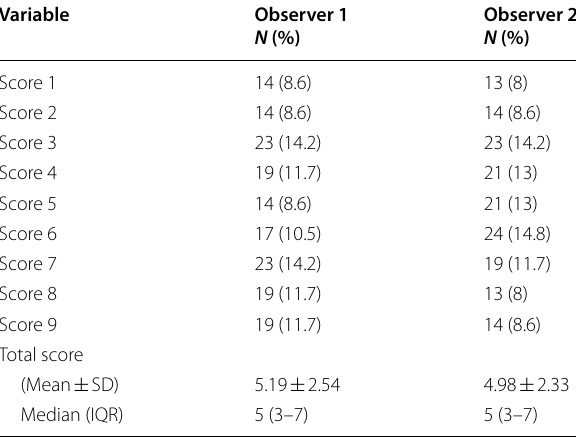
Table 3 Frequency distribution of the scoring system by the 2 observers